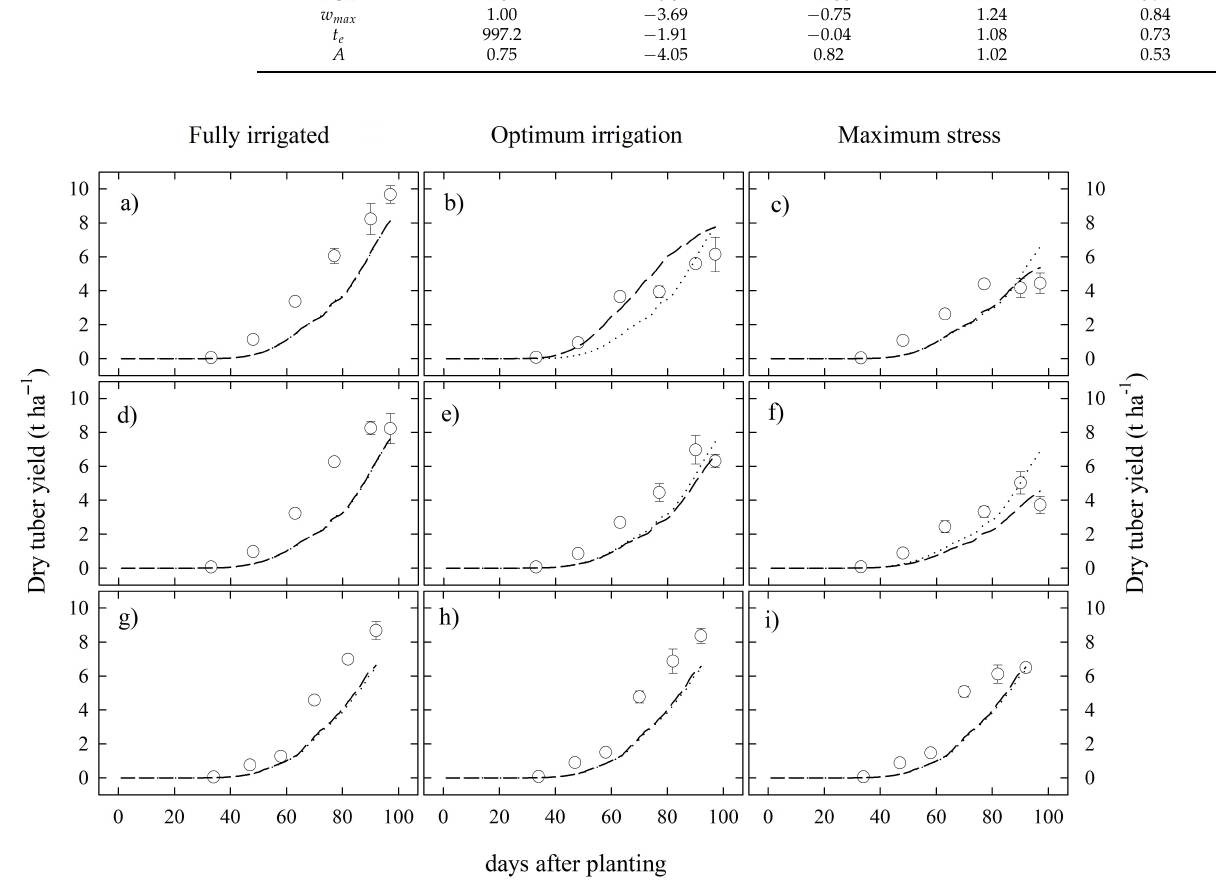
Figure 2. Average values ( ± standard error) of observed (open circles) and simulated dry tuber yield temporal dynamics of the UNICA potato variety for Trials A and C. Simulated values of the water-limited module (1st perspective, dotted line) and canopy temperature module (2nd perspective, dashed line) of the SOLANUM model. The first ( a – c ), second ( d – f ), and third ( g – i ) row correspond to Trial A’s drip irrigation, Trial A’s furrow irrigation, and Trial C’s drip irrigation,